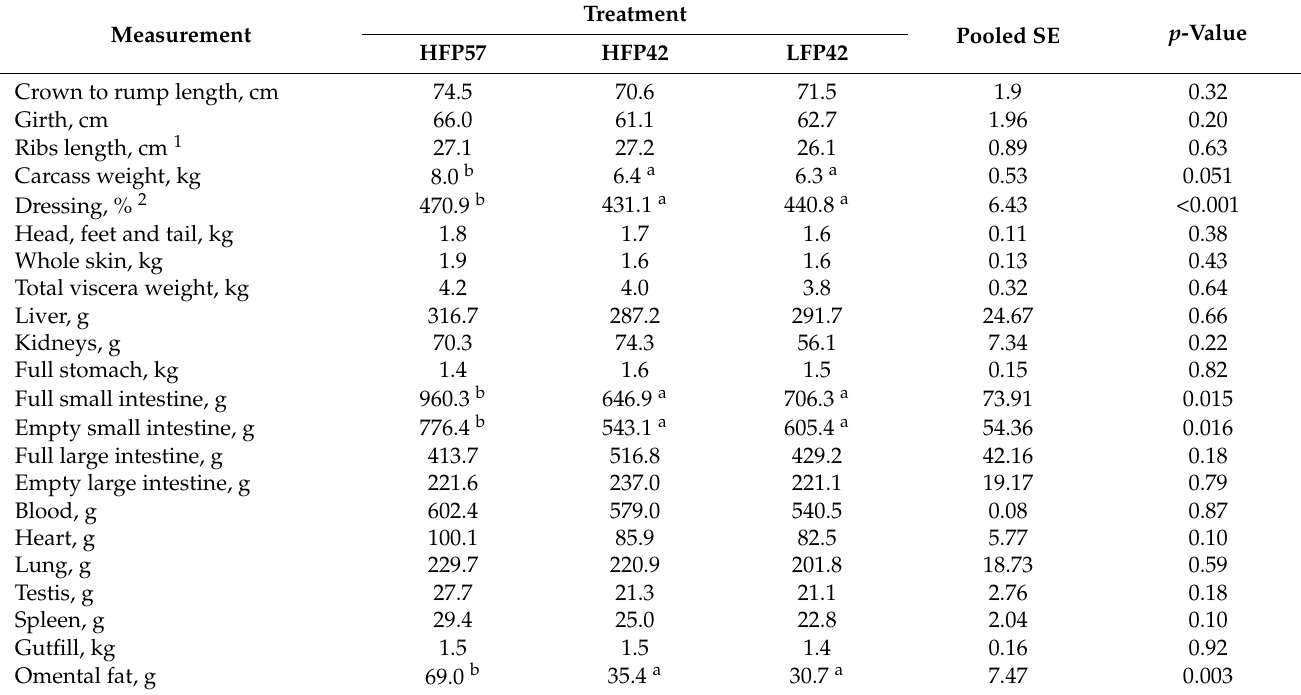
Table 5. Slaughter parameters of lambs reared artificially using three different rearing regimens: HFP57, commercial milk replacer, high fibre concentrate pellets and milk feeding to 57 days of age; HFP42, commercial milk replacer, high fibre concentrate pellets and early weaning at 42 days of age; LFP42, high protein milk replacer from 2–16 days of age followed by commercial milk replacer, low fibre concentrate pellets and early weaning at 42 days of